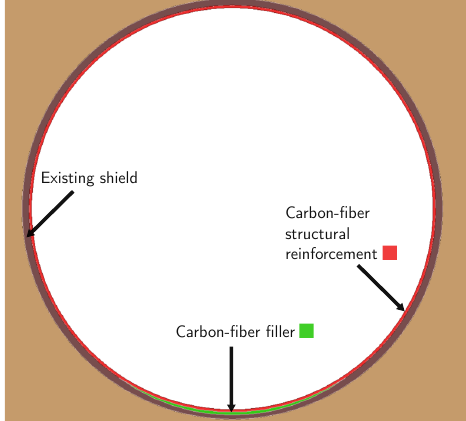
Figure 6. Alternative 3: carbon-fiber internal structural coating